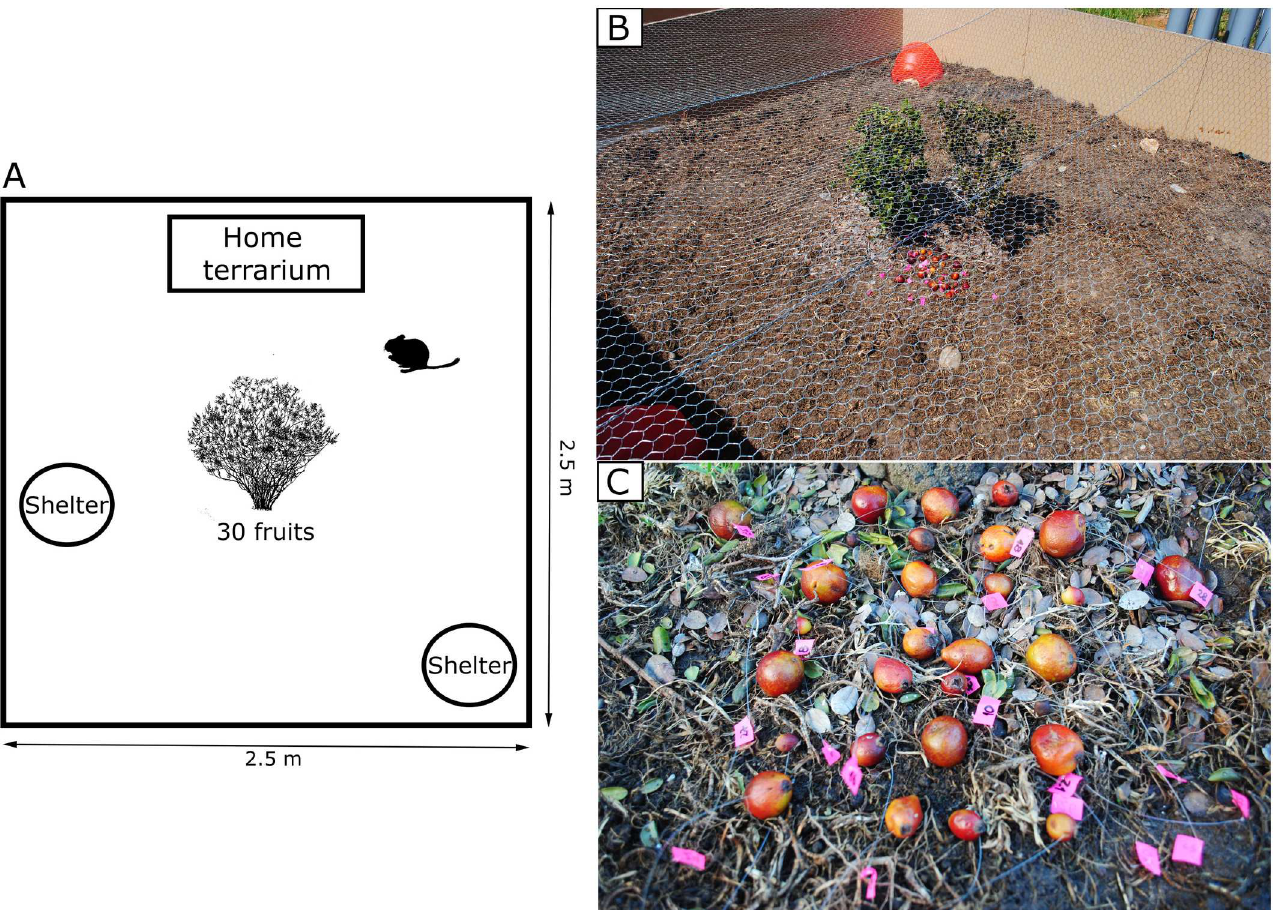
Fig 1. A. Schematicrepresentation of the experimental arena. B. Arena showing the simulated M . coquimbensis shrub at its center with marked fruits underneath it; a shelter is also visiblein one of the corners of the arena. C. M . coquimbensis fruits showingthe fishingline and